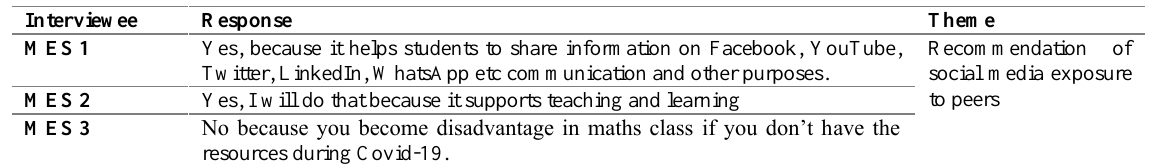
Table 8: Question 8 - Would you recommend social media exposure to any of your peers in either the Mathematics department or any other department? Explain your response.